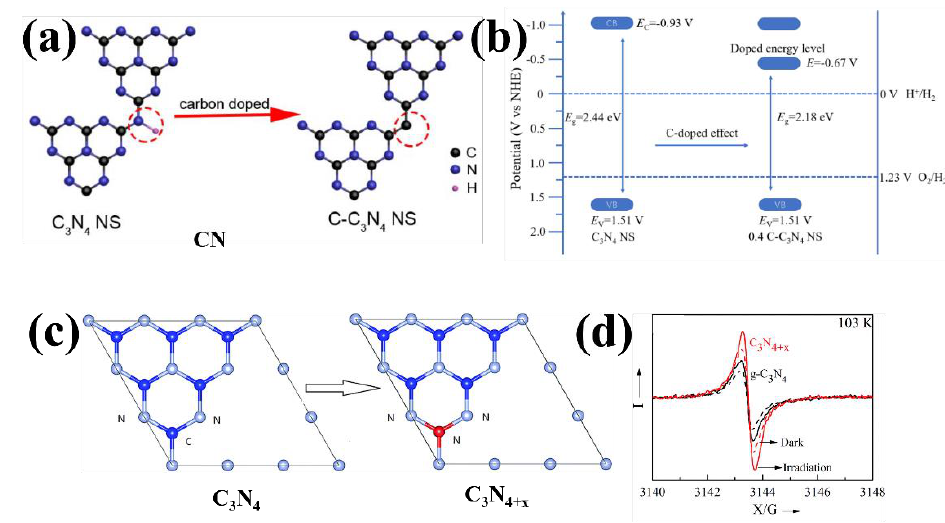
Figure 5. ( a ) Atomic structure and ( b ) bond structure of CN and C–C3N4 NS [48]. ( c ) Schematic of the structure and ( d ) EPR spectra for C3N4 and C3N 4+x [49].